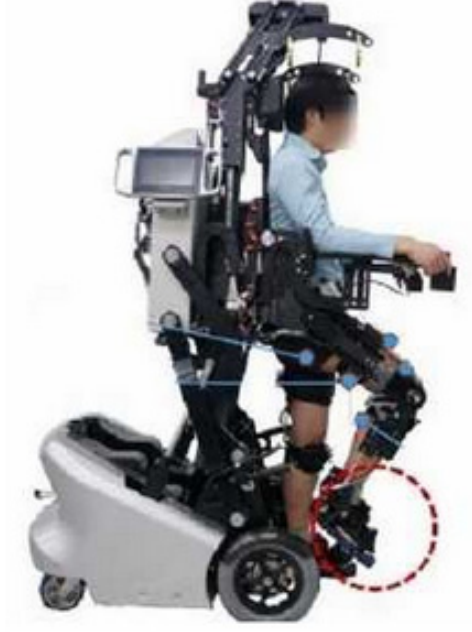
Figure 3. EXOWheel.